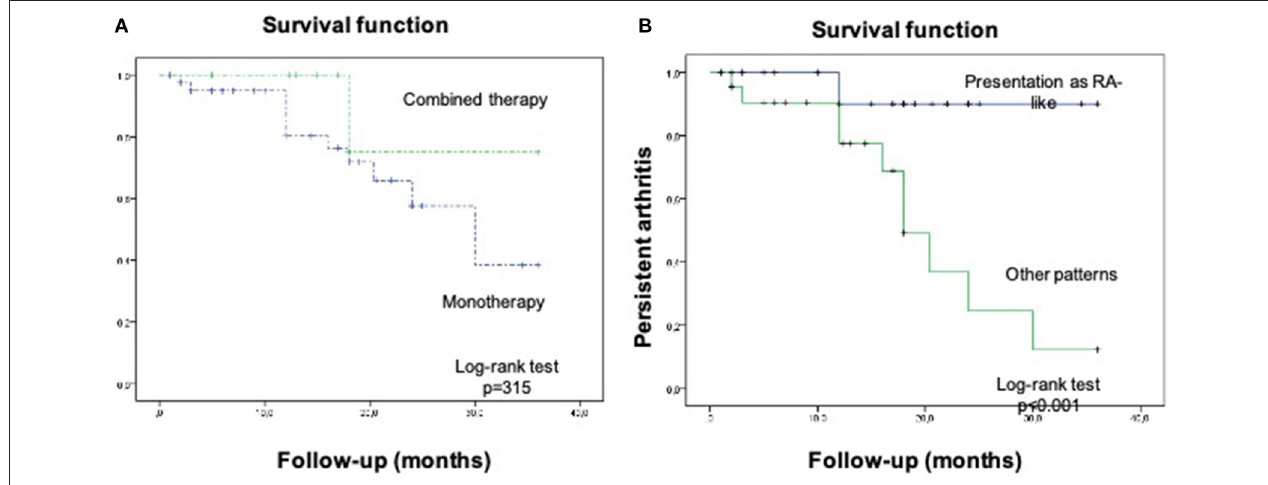
FIGURE 3 | Persistent arthritis in (A) patients with monotherapy vs. combined therapy and (B) patients presented as RA-Like pattern vs. other